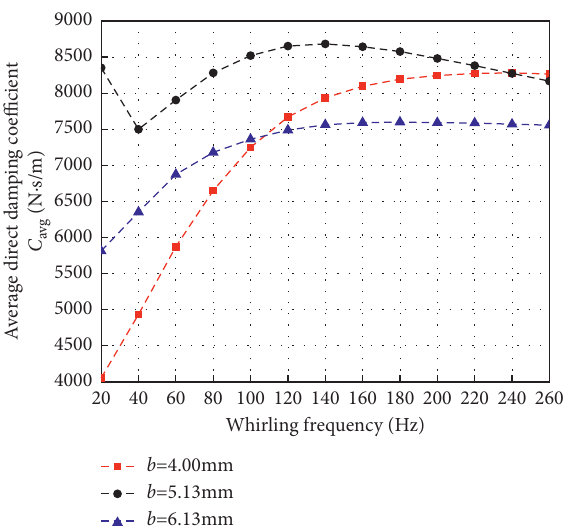
Figure 24: Direct complex dynamic stiffness coefficient vs. whirling frequency.